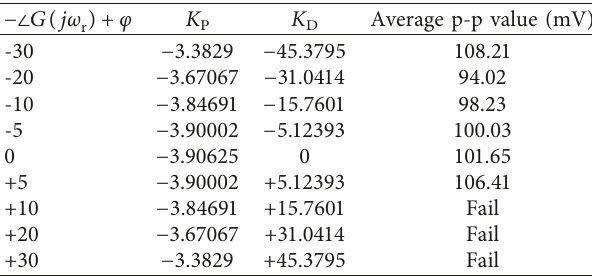
Table 2: Comparison of vibration damping results with changing φ